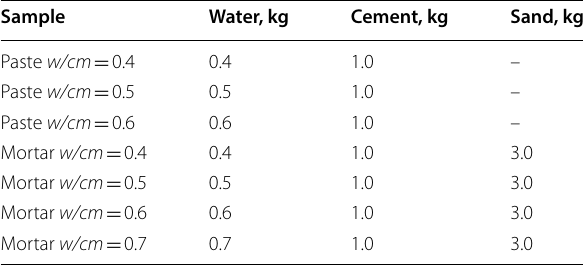
Table 1 Mix proportions of cement and mortar samples. Sample Water, kg Cement, kg Sand,